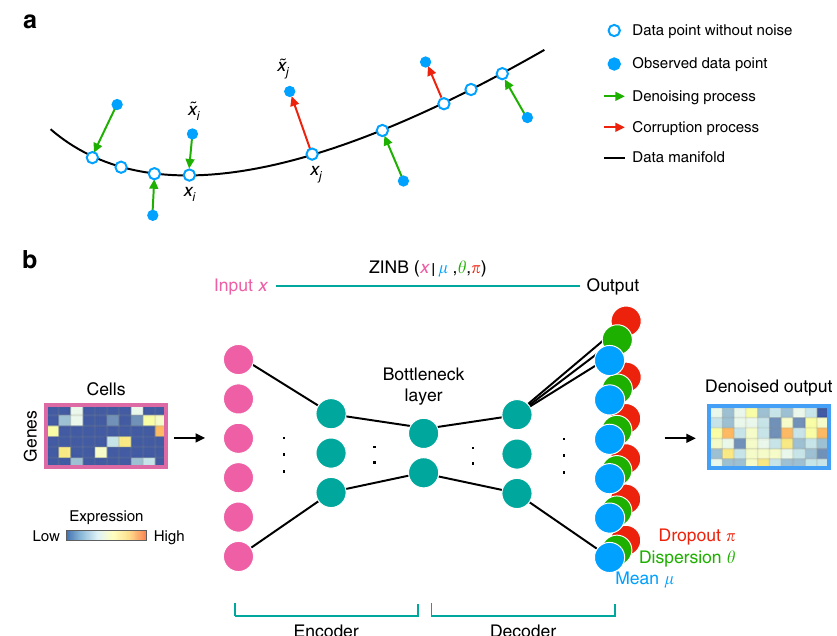
Fig. 1 DCA denoises scRNA-seq data by learning the underlying true zero-noise data manifold using an autoencoder framework. a Depicts a schematic of the denoising process adapted from Goodfellow et al. 24 . Red arrows illustrate how a corruption process, i.e. measurement noise including dropout events, moves data points x j away from the data manifold (black line). The autoencoder is trained to denoise the data by mapping measurement-corrupted data points ~ x back onto the data manifold (green arrows). Filled blue dots represent corrupted data points. Empty blue points represent the data points without i noise. b Shows the autoencoder with a ZINB loss function. Input is the original count matrix (pink rectangle; gene by cells matrix, with dark blue indicating zero counts) with six genes (pink nodes) for illustration purposes. The blue nodes depict the mean of the negative binomial distribution which is the main output of the method representing denoised data, whereas the green and red nodes represent the other two parameters of the ZINB distribution, namely dispersion and dropout. Note that output nodes for mean, dispersion and dropout also consist of six genes which match six input genes. The matrix highlighted in blue shows the mean value for all cells which denotes the denoised expression. and the mean matrix of the negative binomial component represents the denoised output (blue rectangle). Input counts, mean, dispersion and dropout probabilities are denoted as x , μ , θ and π ,